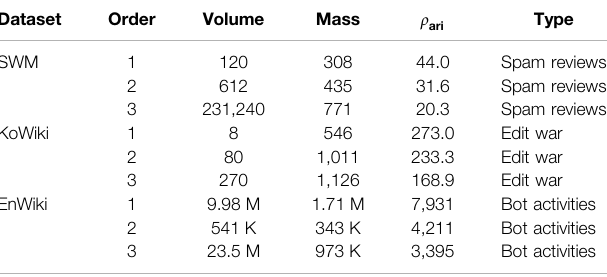
TABLE 6 | Summary of the dense subtensors that D-CUBE detects in the SWM, KoWiki, and EnWiki datasets. Dataset Order